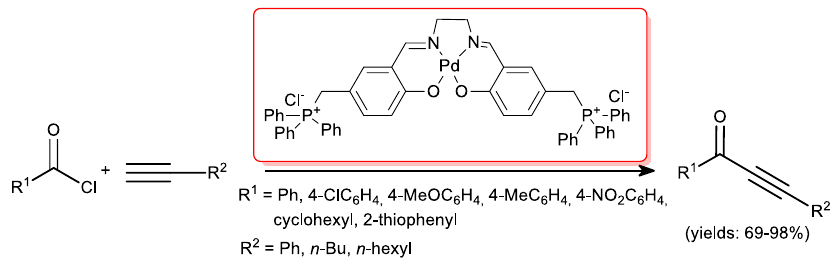
Scheme 18. Palladium-salen complex as a catalyst for acyl Sonogashira reactions.